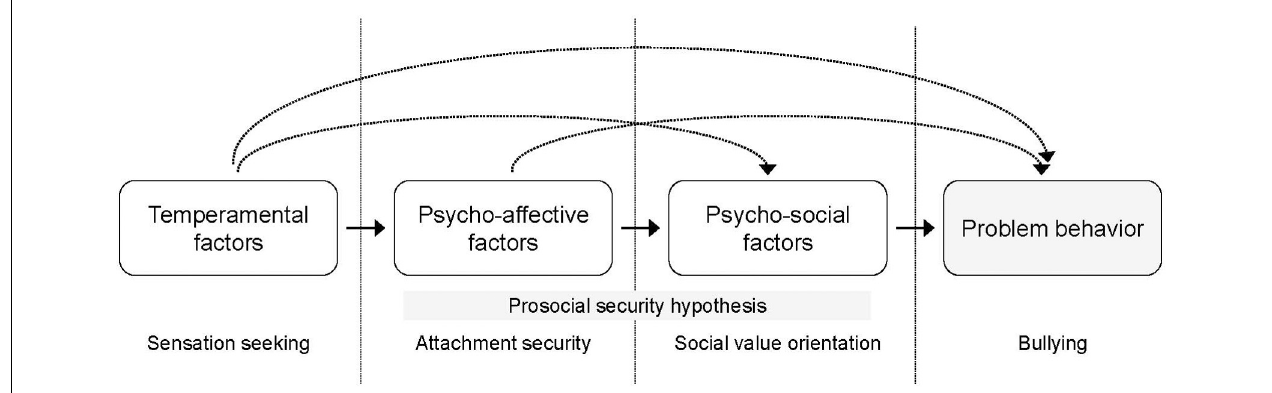
FIGURE 1 | A unifying view of the relationships between temperamental, psycho-affective and psycho-social factor affecting problem behavior in adolescence.